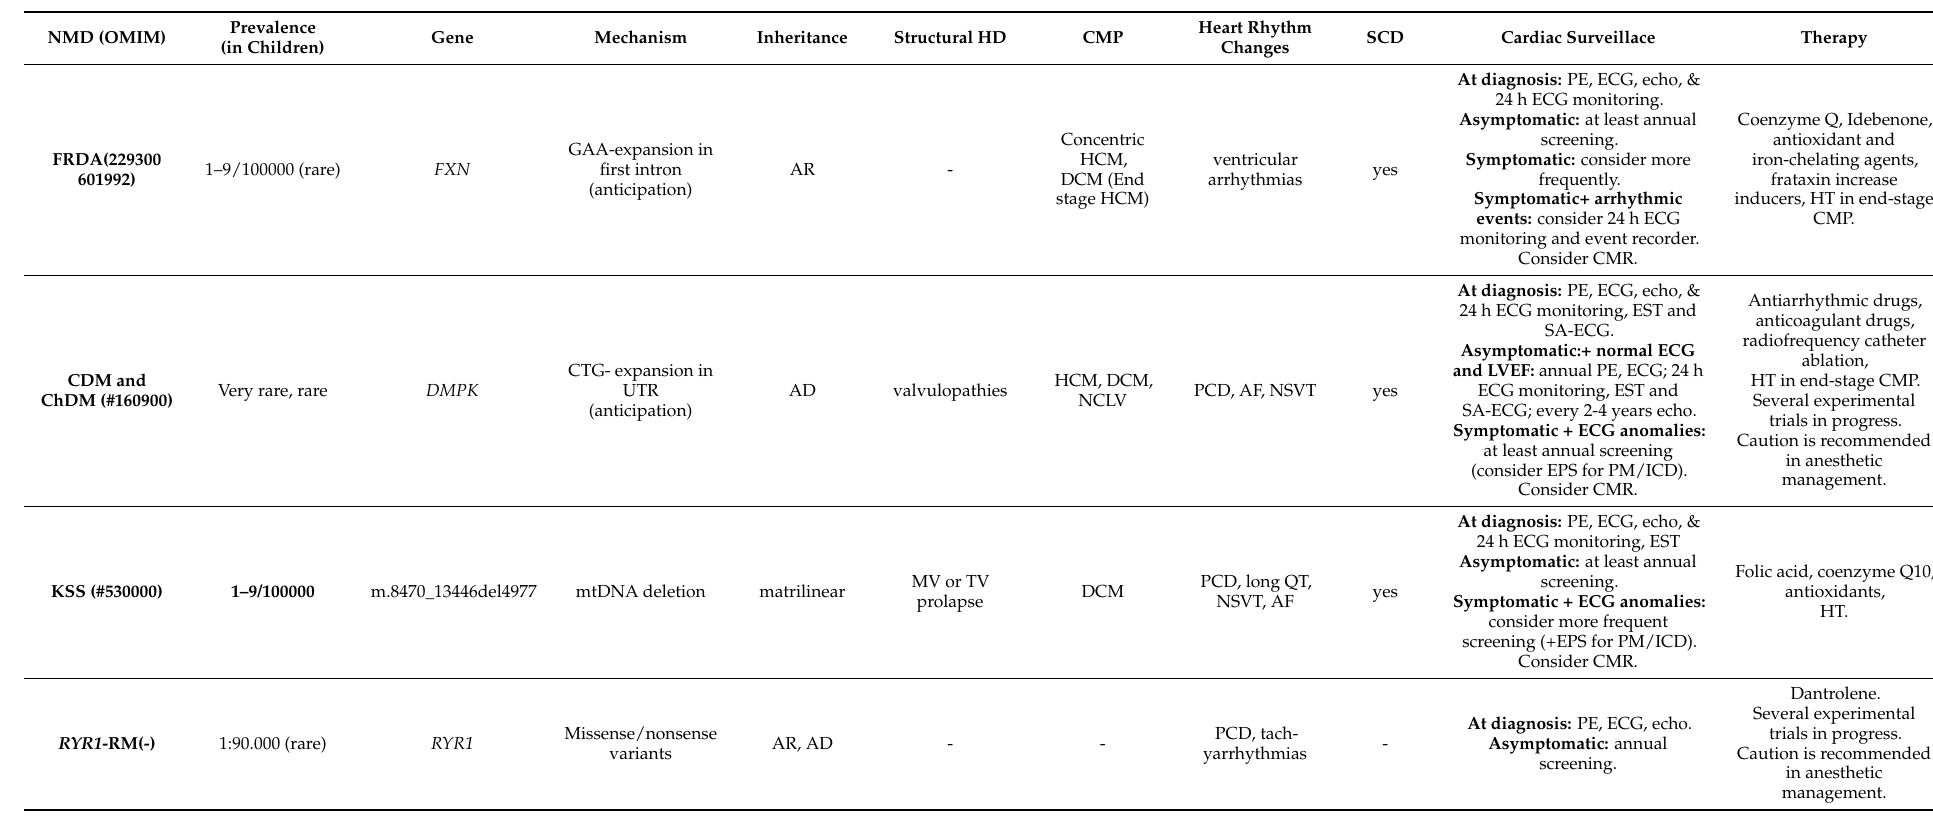
Table 1. Summary of the Main Cardiac Characteristics of Children Affected by the Discussed NMDs including Main Indications for Their Follow Up and Treatment